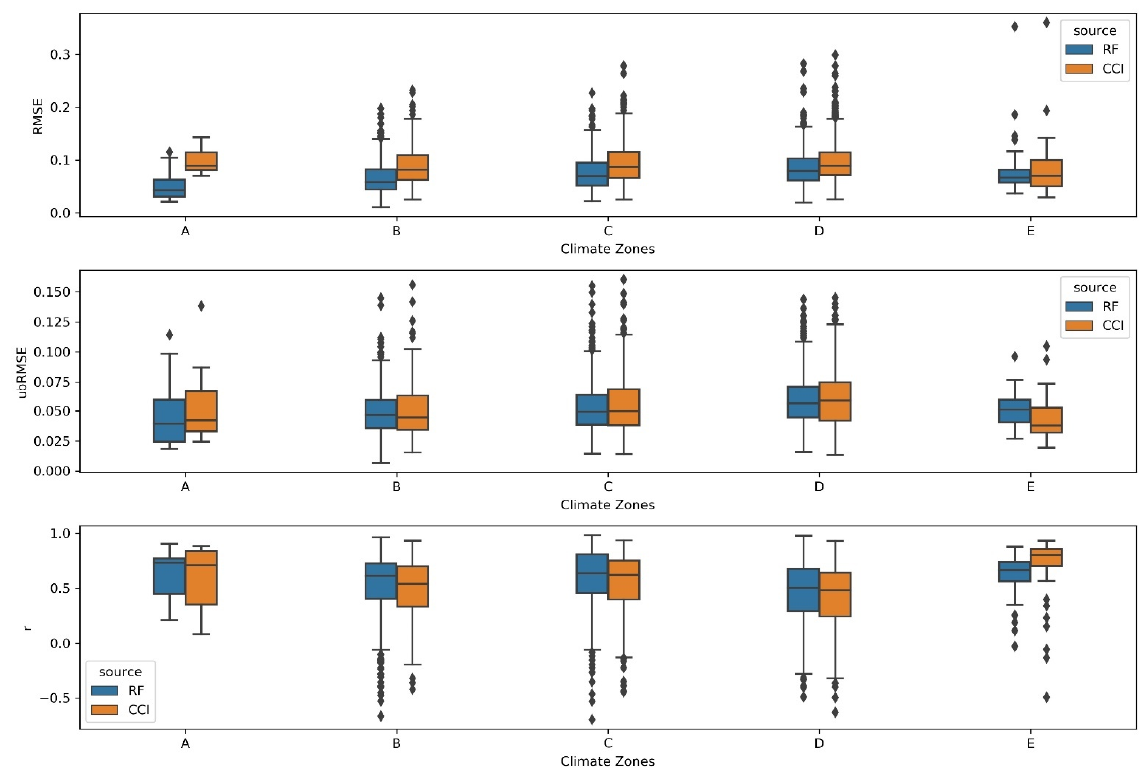
Figure 13. Comparison of SSM and ESA-CCI SSM with in situ data over different climate zones. ( A ) Tropical; ( B ) Arid; ( C ) Temperate; ( D ) Continental; ( E ) Polar.